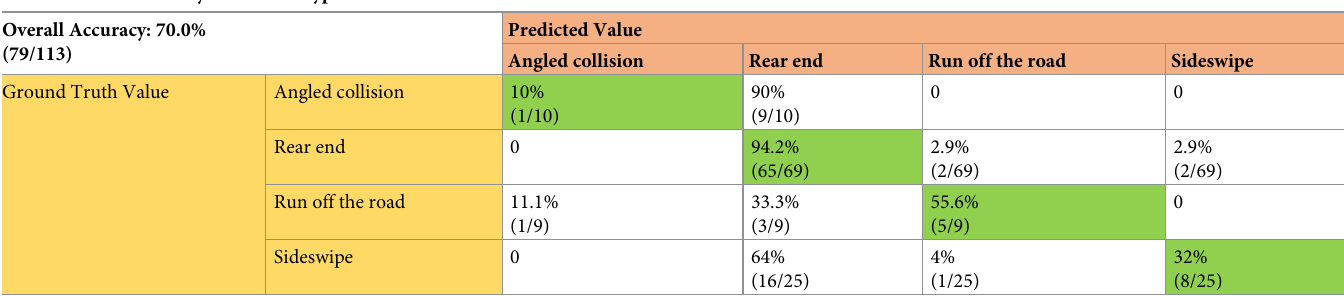
Table 5. Model accuracy of collision types in classification